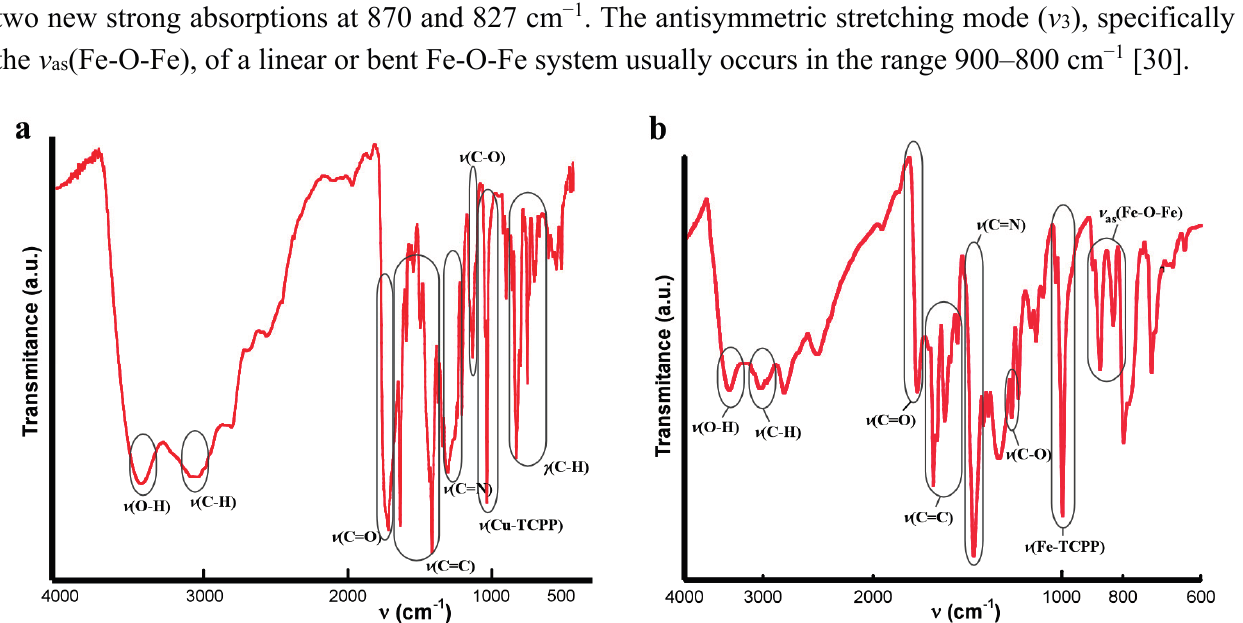
Figure 6. IR spectra for compounds ( a ) 1 and ( b ) 2